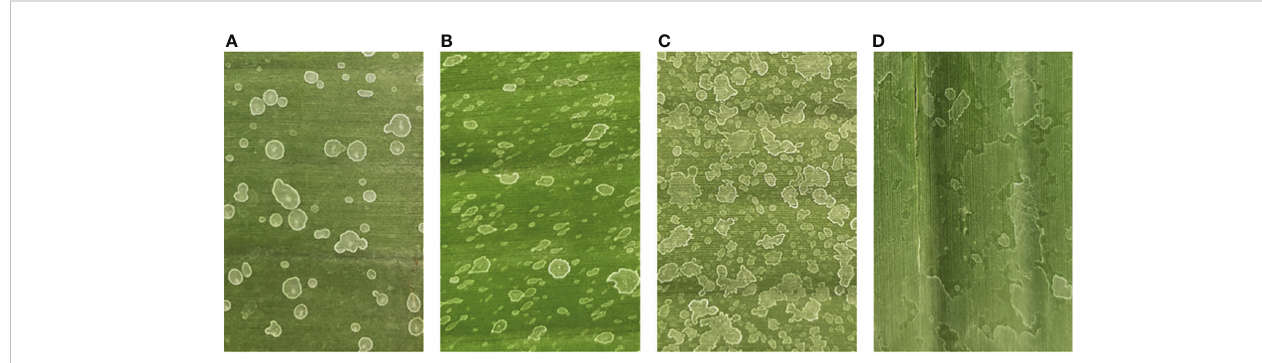
FIGURE 8 Spray droplets deposition incomplete (A) , uniform (B) , accumulate (C) and slippage (D)